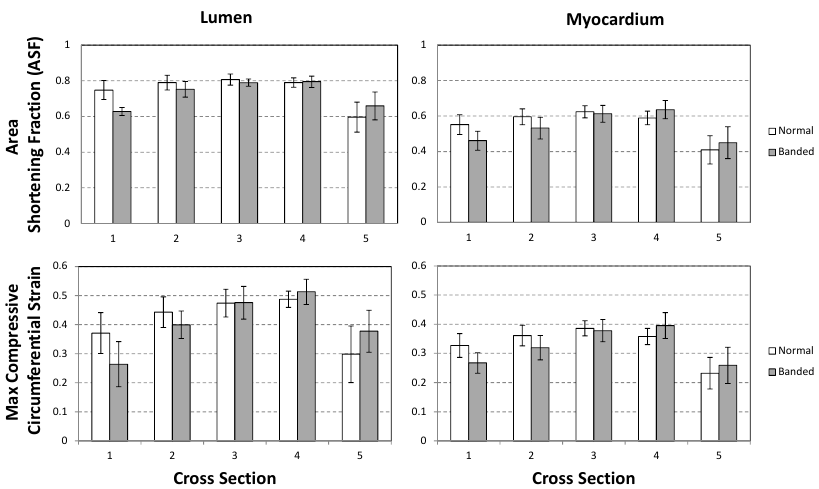
Cross Section Figure 2. Comparison of OFT wall motion of control and banded embryos. Analysis was done based on 4D OCT images (control n = 7; banded n = 6), with cross-sectional locations indicated in Figure 1. The data compares ASF on top (Equation (2)) and maximum compressive circumferential strain on bottom (Equation (3)) for the lumen ( left ) and myocardium ( right ). Data displays average ± SD. Circumferential strains in the myocardium and endocardium of control and banded embryos